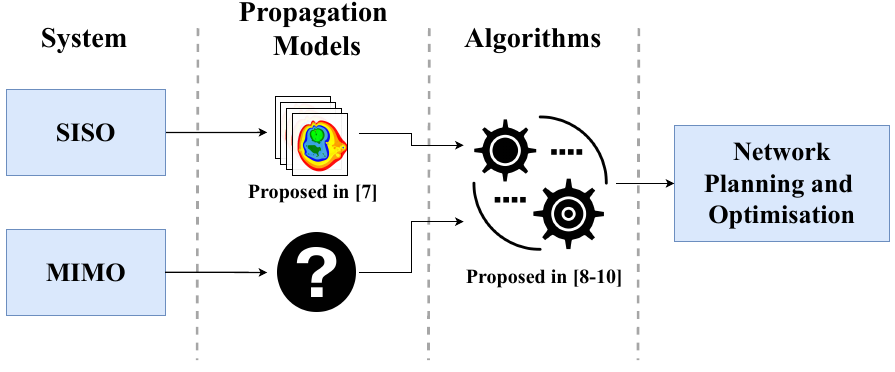
Figure 1. Motivation for this